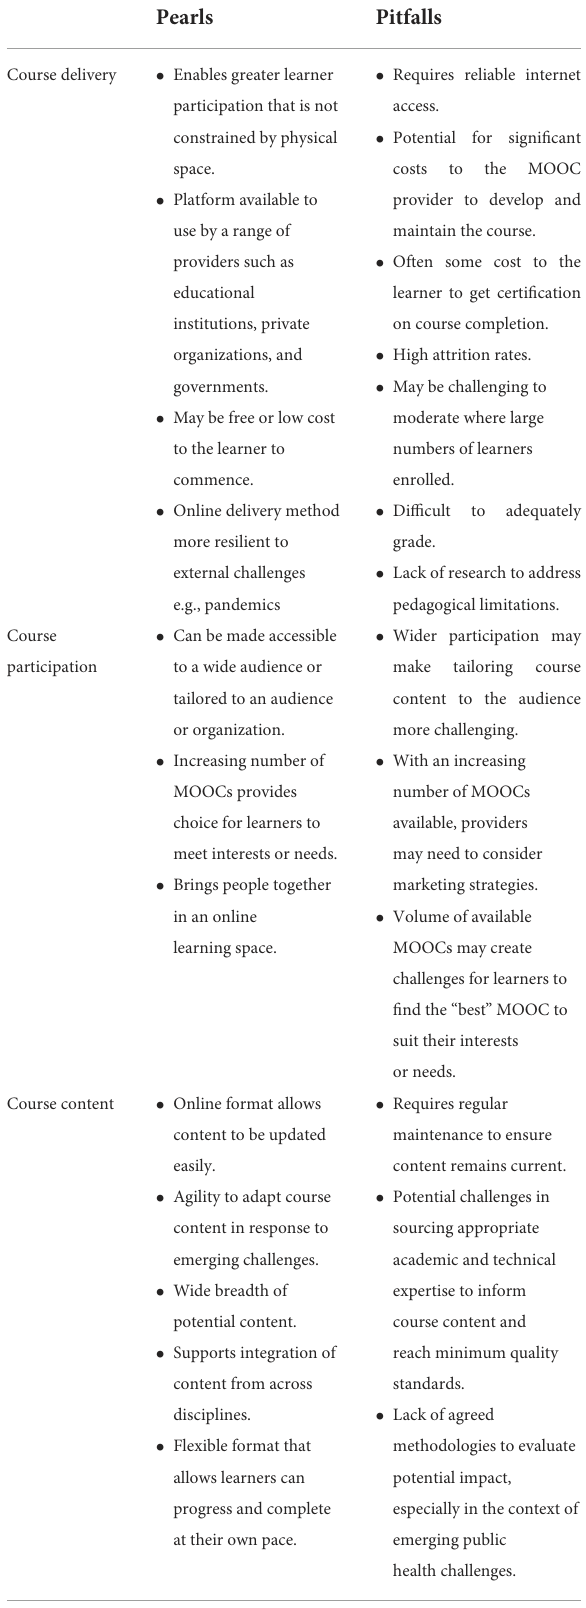
TABLE 1 The pearls and pitfalls of MOOCs in public health.